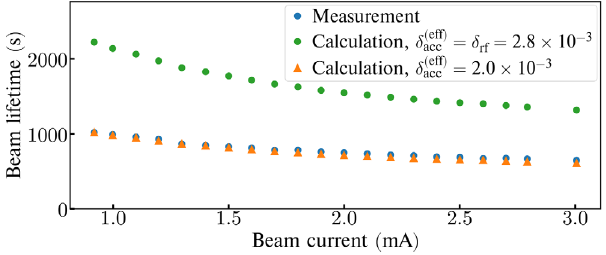
FIG. 8. Lifetime of the round beam in IOTA as a function of beam